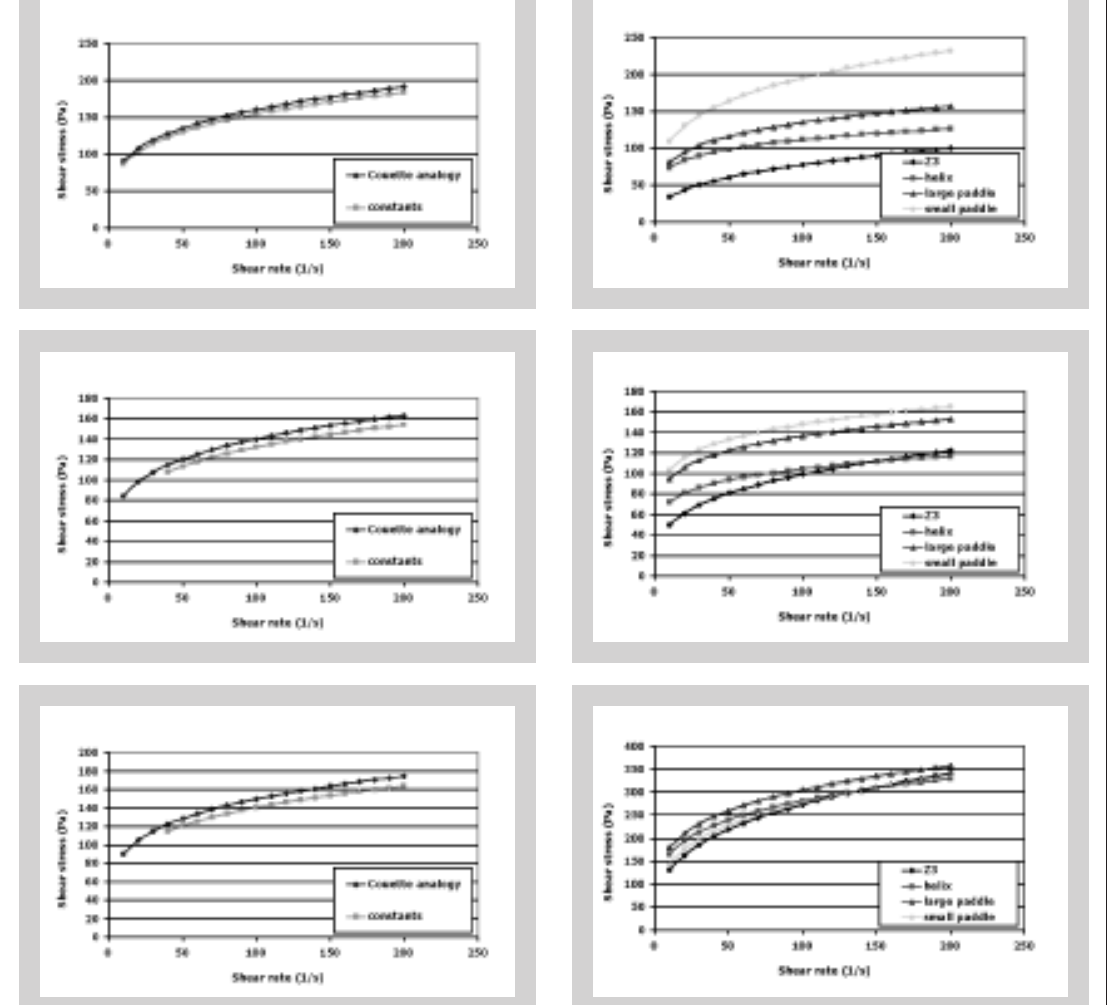
Figure 5a (left above): Shear stress versus shear rate calculated using obtained constants and the method based on the Cou- ette analogy for ketchup using helix. Figure 5b (left middle): Shear stress versus shear rate calculated using obtained constants and the method based on the Cou- ette analogy for ketchup using small paddle. Figure 5c (left below): Shear stress versus shear rate calculated using obtained constants and the method based on the Cou- ette analogy for ketchup using large paddle. Figure 6 (right above): Shear stress versus shear rate obtained with conven- tional system (Z3) and three evaluated mixer systems for 50% tomato paste. Figure 7a (right middle): Shear stress versus shear rate obtained with conven- tional system (Z3) and three evaluated mixer systems for 30% tomato paste contain- ing 3% Microlys. Figure 7b (right below): Shear stress versus shear rate obtained with conven- tional system (Z3) and three evaluated mixer systems for 30% tomato paste contain- ing 5%